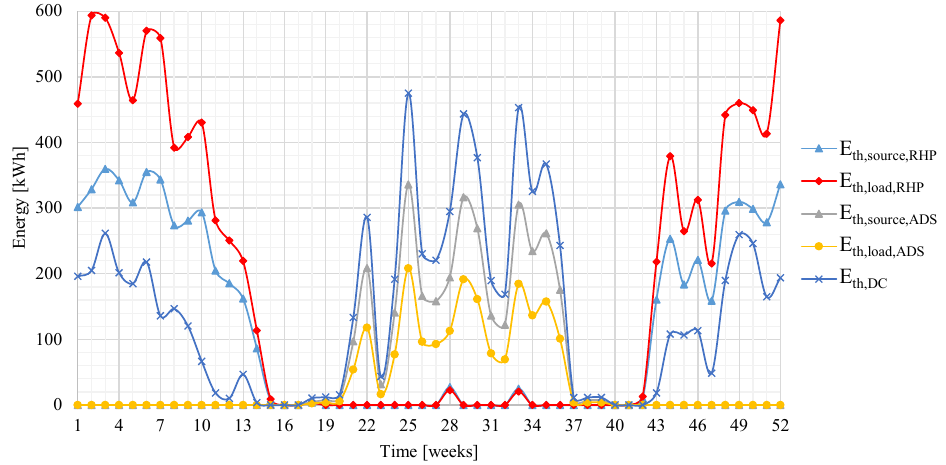
Figure 10. Thermal energy flows of RHP, ADS, and DC, weekly analysis.